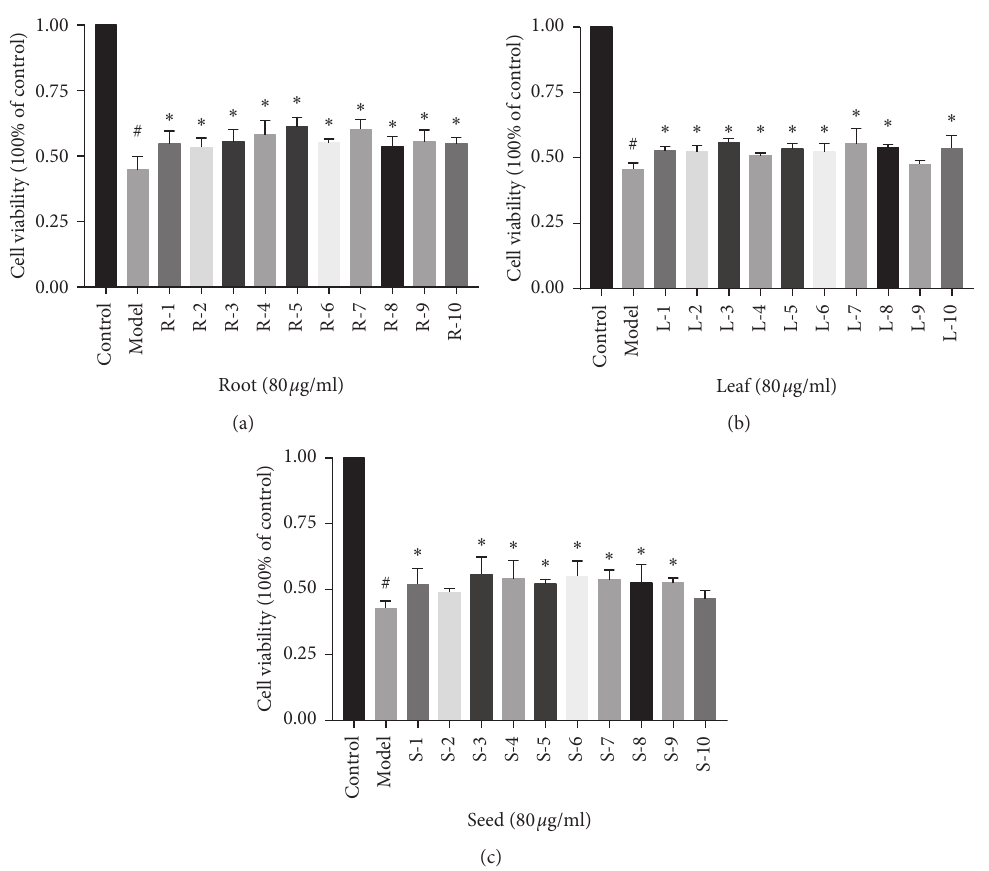
Figure 4: Survival rate of H 2 O 2 -induced PC12 cells after pretreatment with different parts of Acanthopanax senticosus ( X ± S n compared to the control group, # p < 0 . 05; compared to the H 2 O 2 group, ∗ p < 0 .